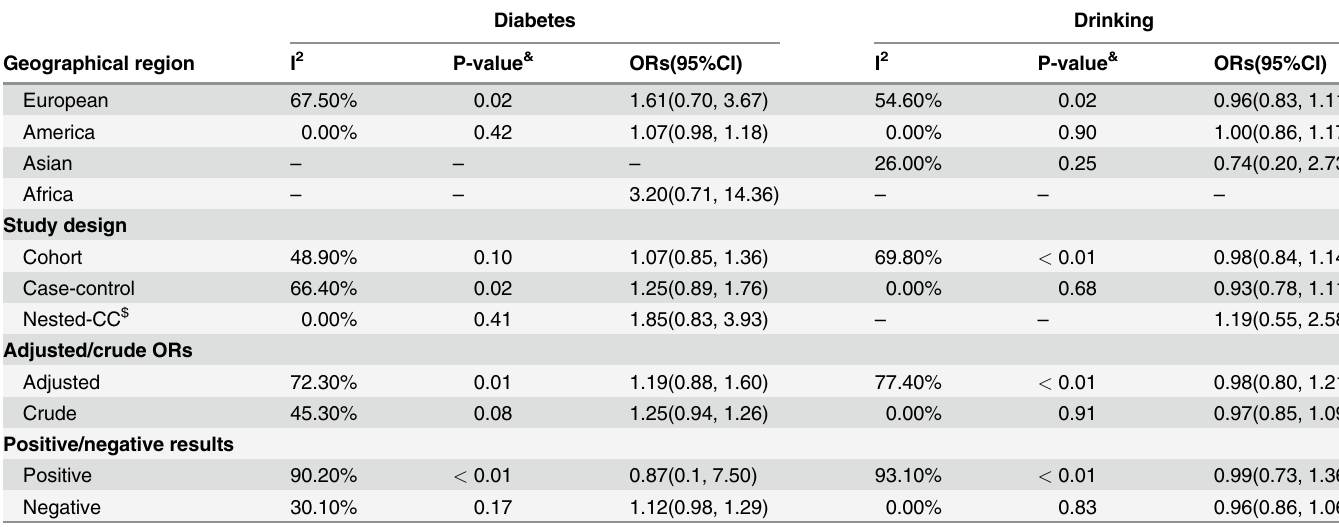
Table 2. The results of subgroup analysis of diabetes and